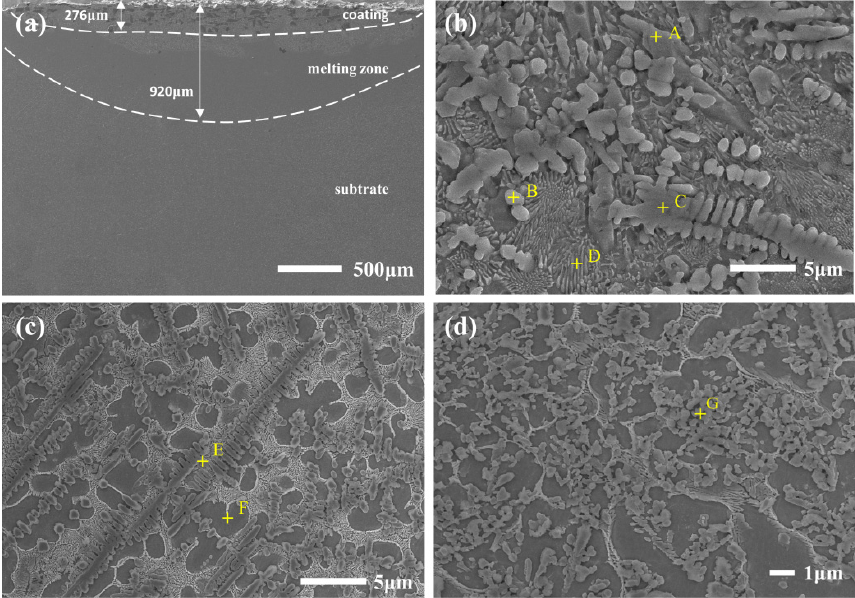
Figure 6. ( a ) Cross-sectional morphology of composite layer; microstructure of composite layer ( b ) top area; ( c ) central area; ( d ) bottom area.